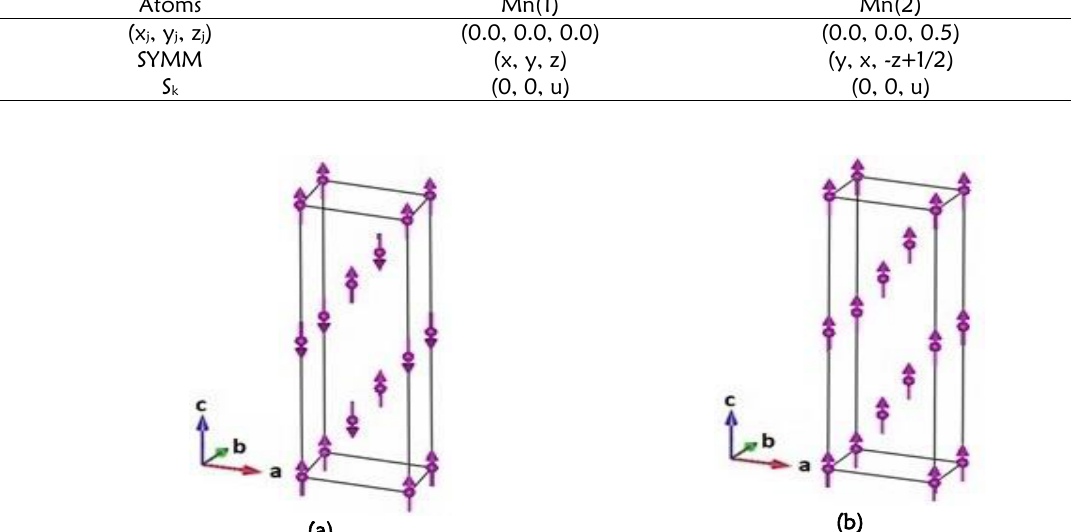
Figure 10. The antiferromagnetic structure (a), and ferromagnetic structure (b) of Ba-doped LaMnO 3